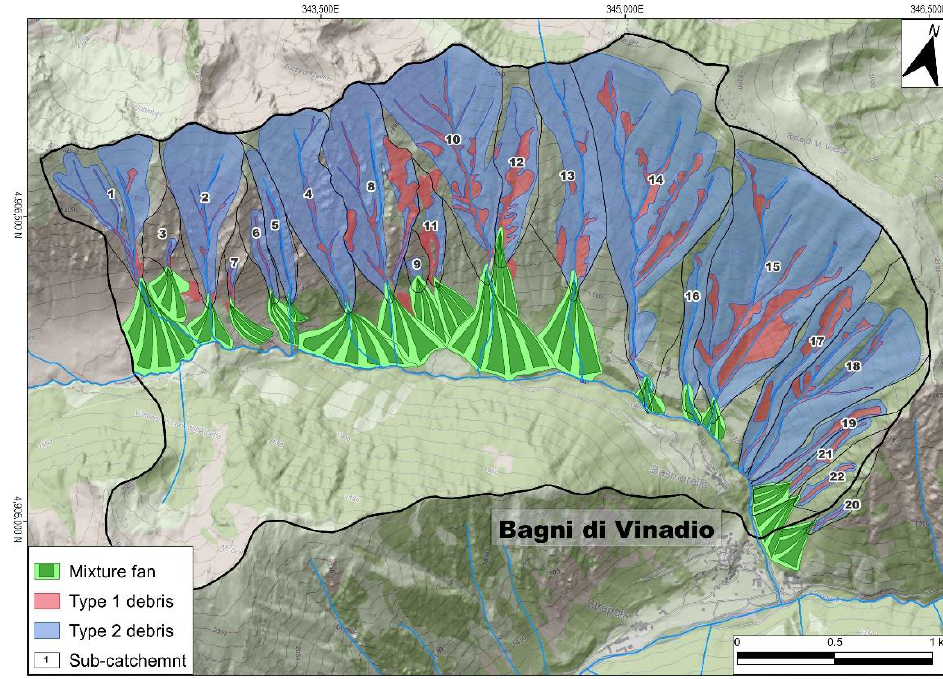
Figure 9. Identification of the areas of movable detritus along the secondary hydrographic network immediately available for mass transport (red areas) and of the areas of unstable debris cover, potentially movable along the slopes of the respective basins due to slope processes (landslides) activated during torrential events (blue areas). Tropeano and Turconi method [60].